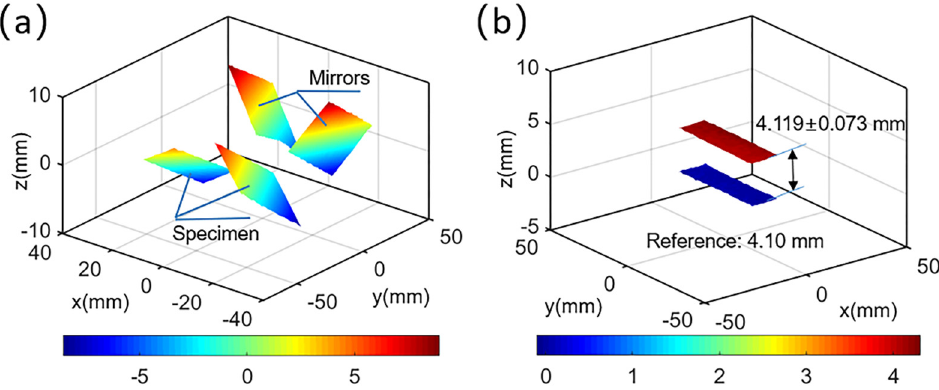
Figure 8. ( a ) Reconstructed shapes of the two planar mirrors and the plate; ( b ) dual surfaces of the plate object after reflection transformation.